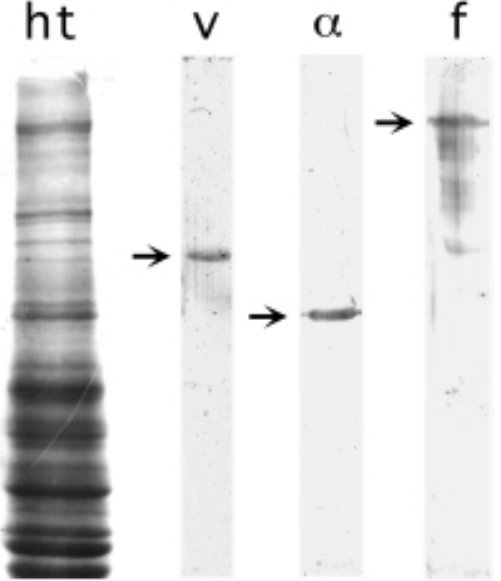
Fig. 5 – Polyacrylamide gel electrophoresis with SDS of a total homogenate (ht) from the main electric organ of E. electricus , stained with Coomassie blue; Immunoblottings using antibod- ies anti-vinculin (v), anti-alpha-actinin ( α ) and anti-filamin (f) against a cytoskeletal-enriched membrane fraction. Arrows indi- cate the main protein bands recognized by the